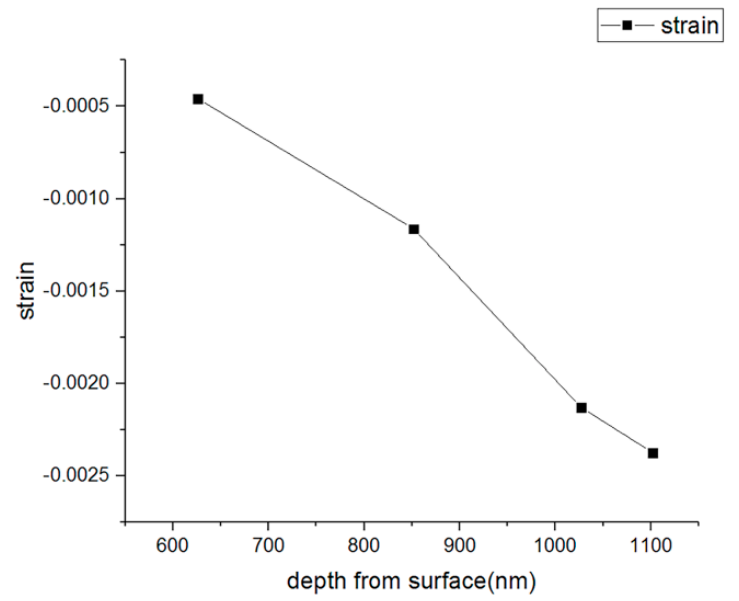
Figure 7. Relaxed residual stress measurement of an Ag thin film of FIB-DIC.